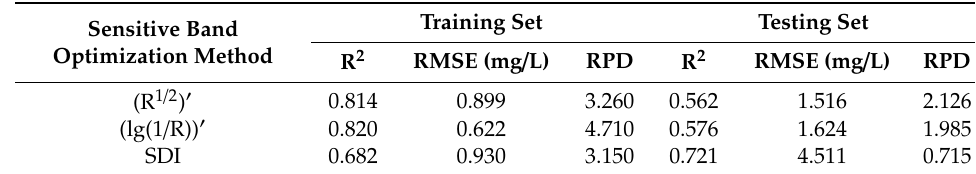
Figure 5. Estimation results for the total nitrogen concentration using a PSO-SVM model (the triangle in the figure represents the testing sample). Table 5. Estimation accuracy of the optimal models based on spectral transformation and the spectral index.